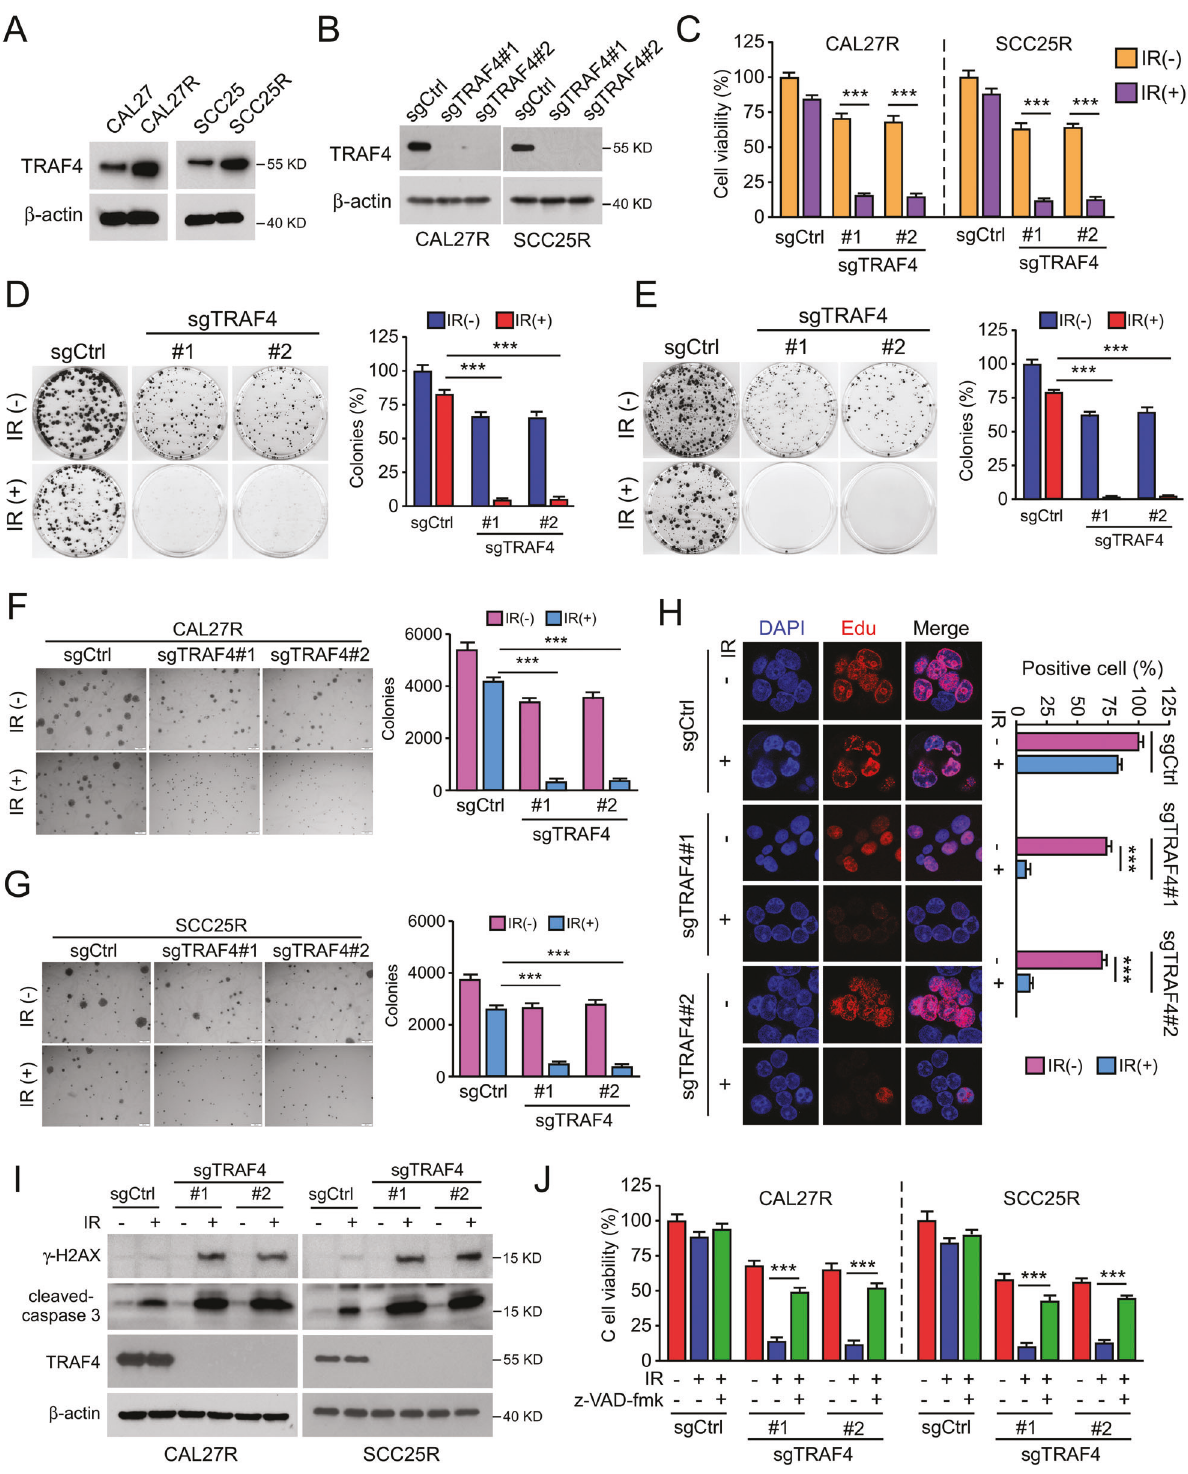
Fig. 2 TRAF4 is required for maintaining tumor cells radioresistance. A Immunoblotting for TRAF4 expression in CAL27/CAL27R and SCC25/ SCC25R cells. B Immunoblotting for TRAF4 expression in TRAF4 knockout CAL27R and SCC25R cells. C MTS assay was used to determine the cell viability of TRAF4 knockout in CAL27R and SCC25R cells treated with/without IR (2 Gy) for 72 h. D , E Plate colony formation assay was performed to analyze the colony formation of TRAF4 knockout in CAL27R ( D ) and SCC25R ( E ) cells treated with/without IR (2 Gy) for 72 h. F , G Soft agar assay were employed to assess the anchorage-independent cell proliferation of TRAF4 knockout in CAL27R ( F ) and SCC25R ( G ) cells treated with/without IR (2 Gy) for 72 h. H The representative image of the Edu incorporation assay for TRAF4 knockout in CAL27R cells treated with/without IR (2 Gy) for 72 h. I TRAF4-null CAL27R and SCC25R cells were treated with/without IR (2 Gy) for 72 h. WCE was prepared with the RIPA buffer. γ -H2AX and cleaved-caspase 3 expressions were determined by immunoblotting. J Pretreated with z-VAD-fmk inhibitor for 4 h, MTS assay was used to determine the cell viability of TRAF4 knockout in CAL27R and SCC25R cells treated with/without IR (2 Gy) for 72 h. All data are means ± s.e.m. *** p < 0.001, a signi fi cant difference between groups as indicated. Cell Death and Disease